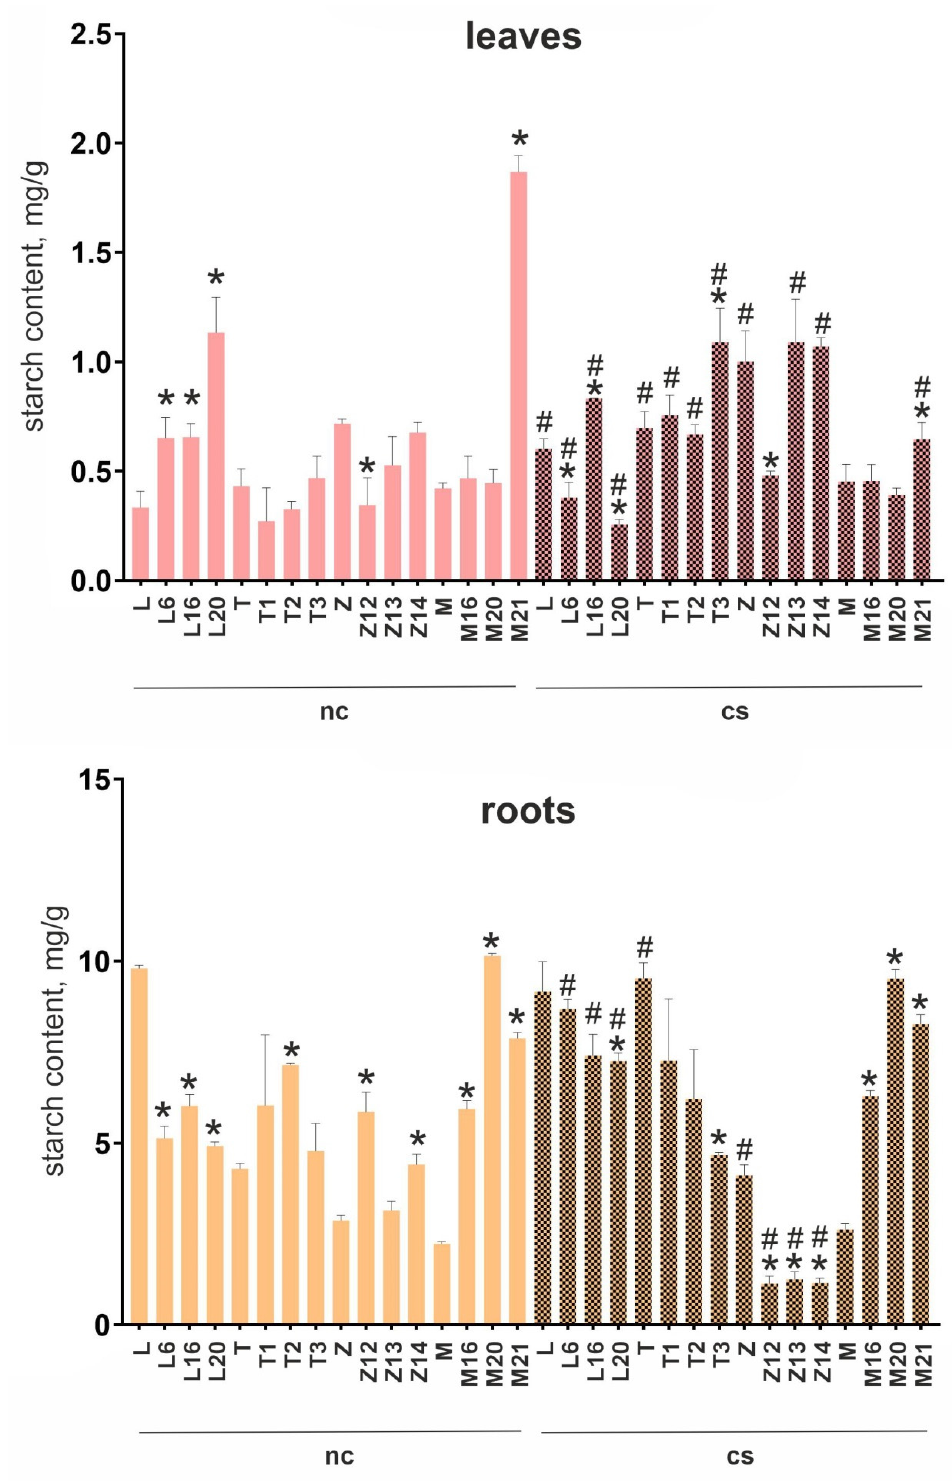
Figure 2. Starch content in the leaves and roots of wild-type potato cultivars Lux (L), Terra (T), Zhukovskii rannii (Z), and Mishka (M) and the corresponding transgenic lines at normal growth conditions (+21 °C; nc) and in response to cold stress (+4 °C for 3 days; cs). The data are presented as the mean ± SD ( n = 3); * p < 0.01—transgenic vs. wild-type plant; # p < 0.01—cold stress vs. normal